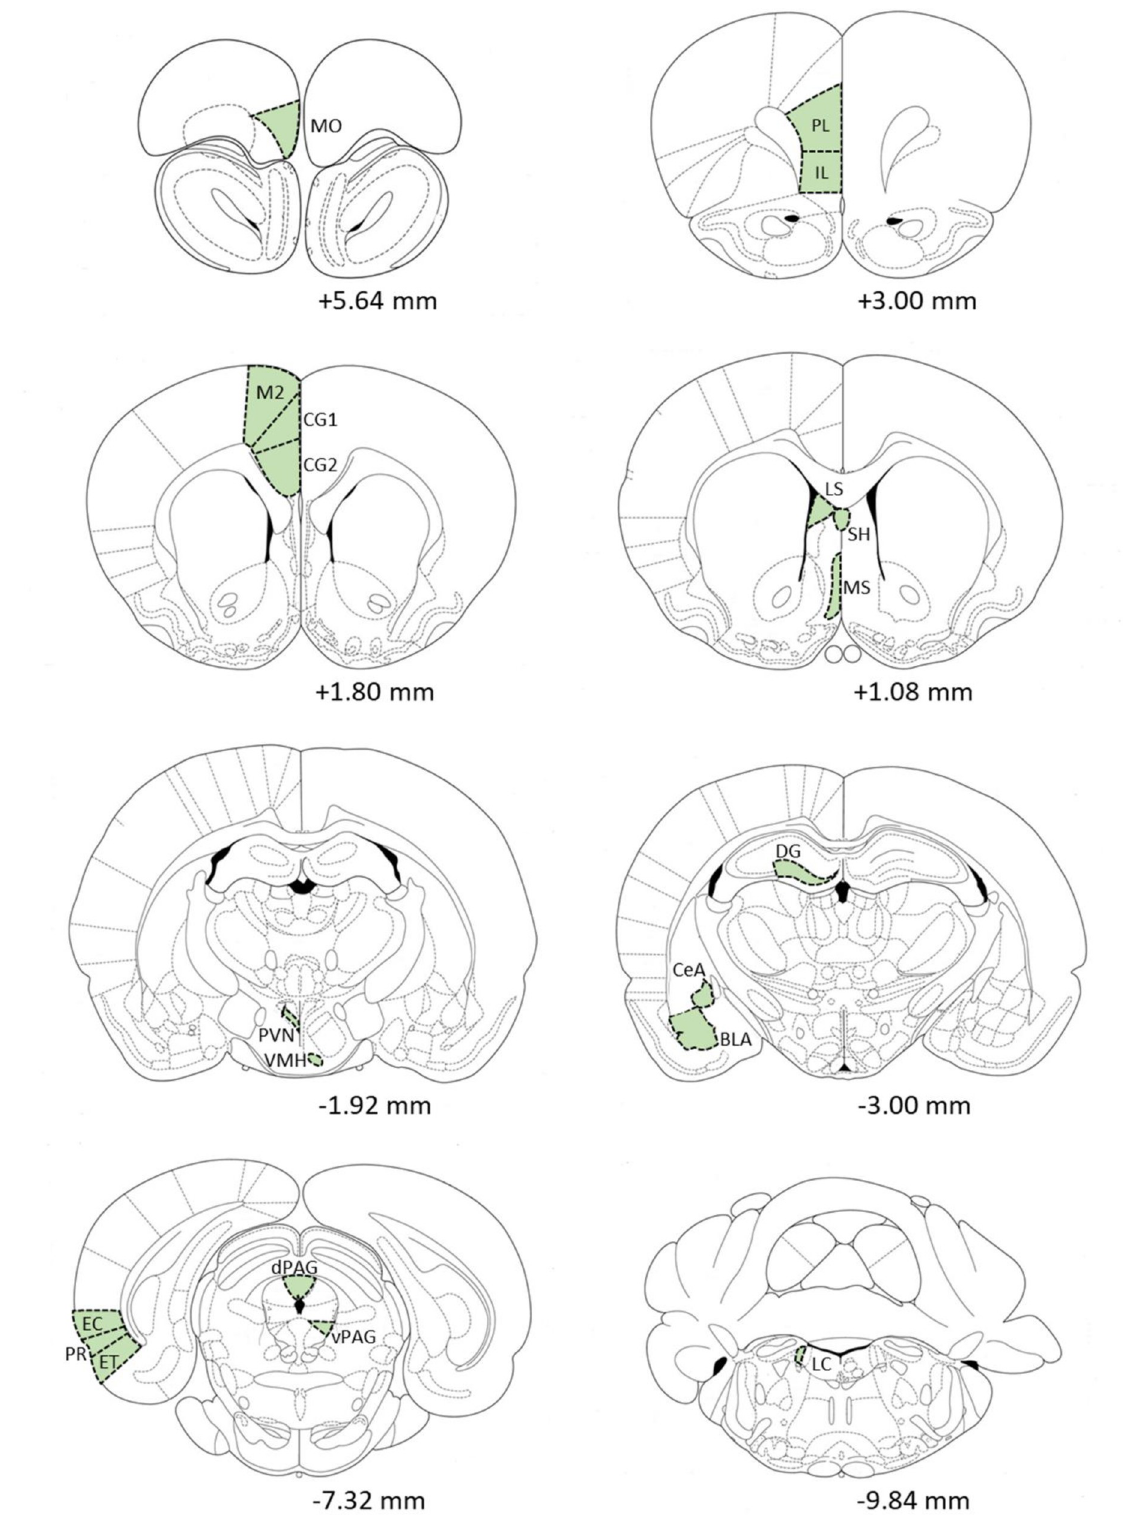
Fig 1. Schematic diagrams, adapted from the atlas of Paxinos and Watson [30], showing the 20 areas (highlighted in green) where Fos expression was quantified. Medial orbital cortex (MO), prelimbic cortex (PL), infralimbic cortex (IL), anterior cingulate cortex—subregion